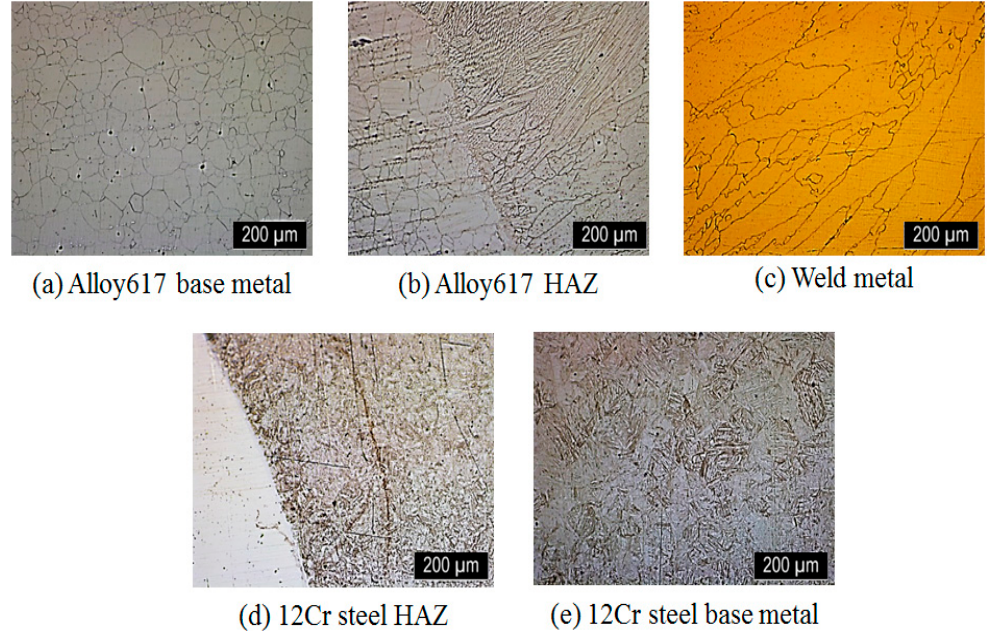
Figure 4. Optical microscope results prior to PWHT; ( a ) Alloy 617 base metal, ( b ) Alloy 617 heat affected zone, ( c ) Weld metal, ( d ) 12Cr steel HAZ, and ( e ) 12Cr steel base metal.